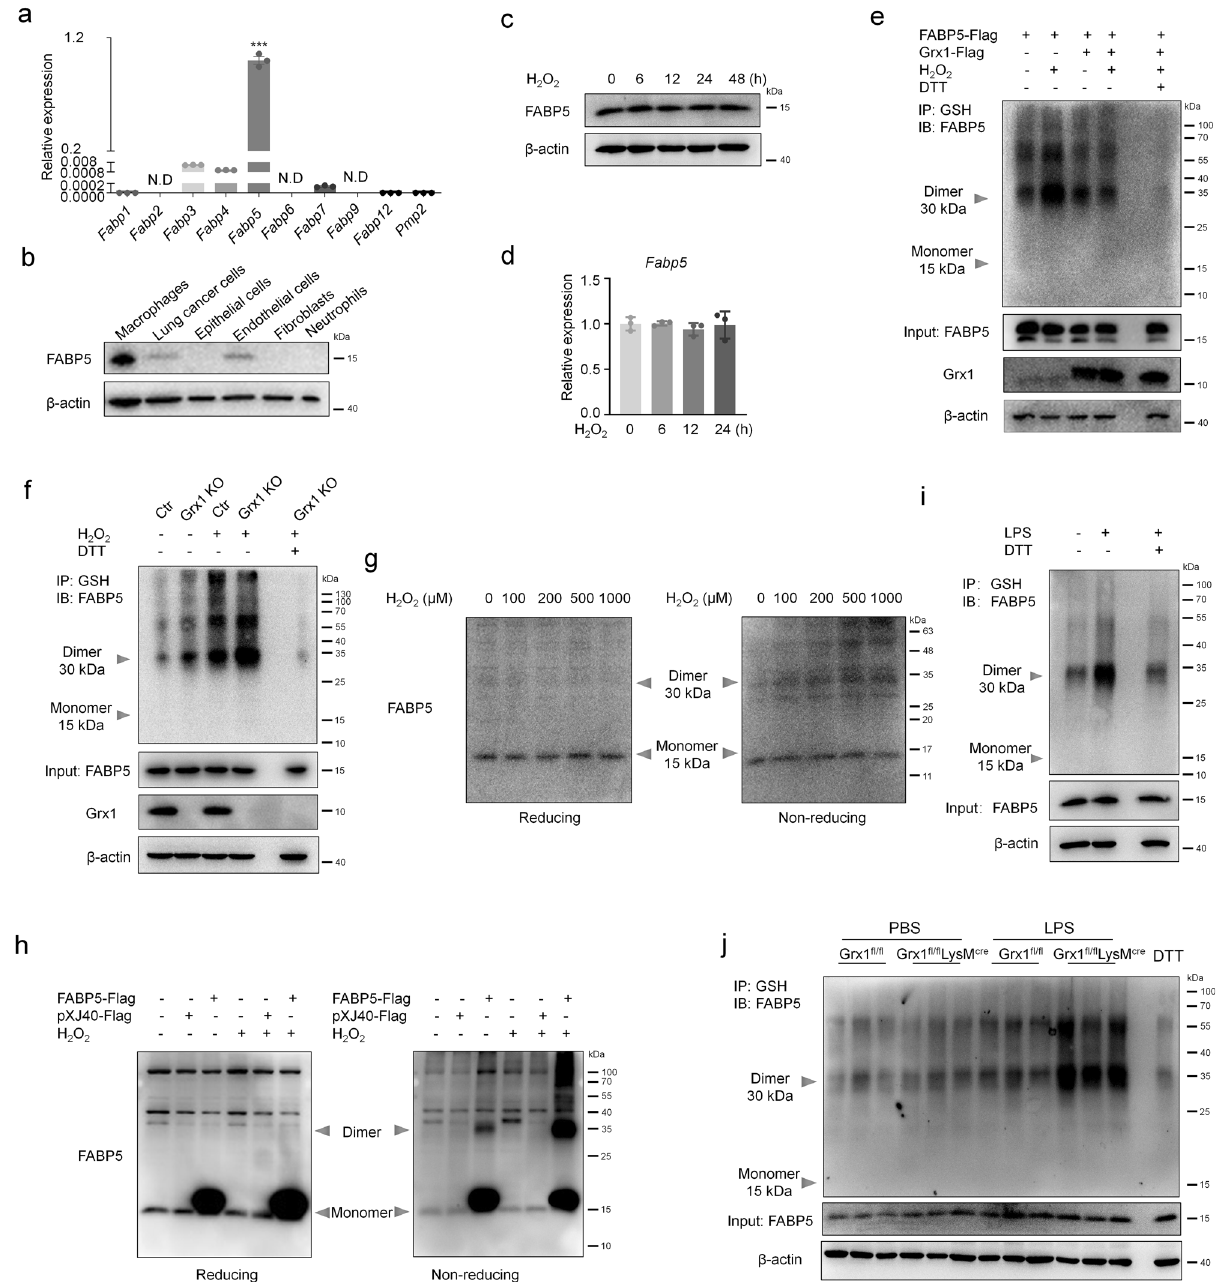
Fig. 4 FABP5 is S-glutathionylated under oxidative stress conditions. a mRNA levels of FABP family members in RAW264.7 cells as determined by qPCR, n = 3 biologically independent samples over three independent experiments, data are presented as mean ± SEM and analyzed with a 95% con fi dence interval, P <0.0001, N.D, not detected, one-way ANOVA is followed by Tukey ’ s post-hoc test. b Protein levels of FABP5 in macrophages (MH-S), lung cancer cells (A549), epithelial cells (MLE-12), endothelial cells (HUVEC), fi broblasts (HFL1), and neutrophils (primary neutrophils) as evaluated by immunoblot. c Levels of FABP5 evaluated by immunoblot in RAW264.7 cells exposed to H 2 O 2 (200 μ M) for indicated time ( β -actin, loading control). d mRNA levels of Fabp5 in RAW264.7 cells after exposure to H μ M) for indicated time as determined by qPCR, n = 3 biologically independent samples over three 2 O 2 (200 independent experiments, data are shown as mean ± SEM and analyzed with a 95% con fi dence interval, one-way ANOVA is followed by Tukey ’ s post-hoc test. e Co-IP of S-glutathionylation of FABP5 in COS-7 cells co-transfected with pXJ40-3xFlag-FABP5 and pcDNA3.1-3xFlag-Grx1 (or vector) and exposed for 15min to H 2 O 2 (200 μ M) at 24h post-transfection (IP, GSH; IB, FABP5). Whole cell lysates con fi rm the expression of FABP5, Grx1, and β -actin (DTT, negative control). f Co-IP showing S-glutathionylation of FABP5 in BMDMs (from control or Grx1 KO mice) after exposure to H 2 O 2 (200 μ M) for 15min (IP, GSH; IB, FABP5). Whole cell lysates con fi rm the expression of FABP5, Grx1, and β -actin (DTT, negative control). g Immunoblotting analysis of reducing or non-reducing SDS – PAGE of RAW264.7 cells after exposure to H 2 O 2 (at the indicated concentration) for 15 min. h COS-7 cell lysates subjected to SDS-PAGE under reducing or non-reducing conditions after transfection of pXJ40-3xFlag vector or pXJ40-3xFlag-FABP5 and exposure to H 2 O 2 (200 μ M) for 15min. i Co-IP for S-glutathionylation of FABP5 in WT BMDMs after treatment with LPS (100ng/mL) for 15min (IP, GSH; IB, FABP5). Whole cell lysates con fi rm the expression of FABP5 and β -actin. j S-glutathionylation of FABP5 in lung tissues from Grx1 fl / fl and Grx1 fl / fl LysM cre mouse 24h following intratracheal administration of PBS or LPS. Source data are provided as a Source Data fi le. NATURE COMMUNICATIONS| (2021) 12:7094 |https://doi.org/10.1038/s41467-021-27428-9|www.nature.com/naturecommunications